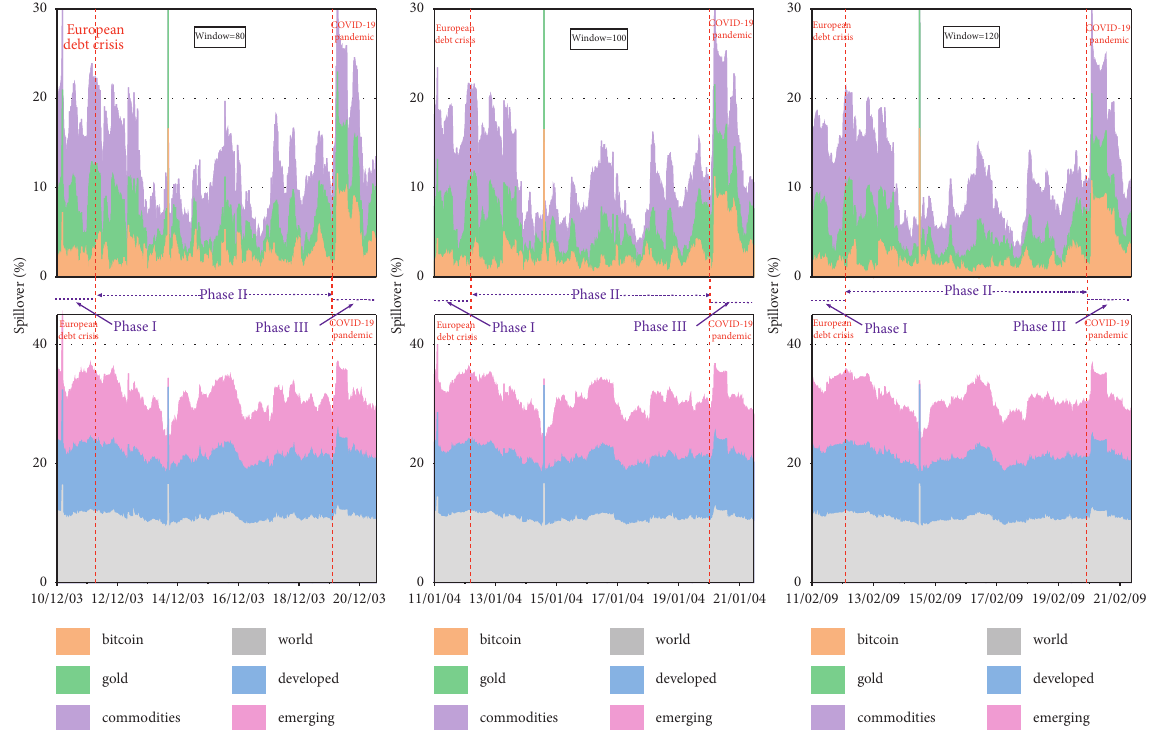
Figure 8: Dynamic net spillover from others with different rolling windows. The red dotted line defines the time points that distinguish three sample phases. The three window sizes plot the dynamic return total spillover measures on the 80 (the sample period for returns is from December 8, 2010, to June 23, 2021), 100 (the sample period for returns is from January 4, 2011, to June 23, 2021), and 120 (the sample period for returns is from February 9, 2011, to June 23, 2021). All abbreviations are as follows: bitcoin, gold, and commodities indices (commodities); the world stock index (world); the developed stock index (developed); and the emerging stock index